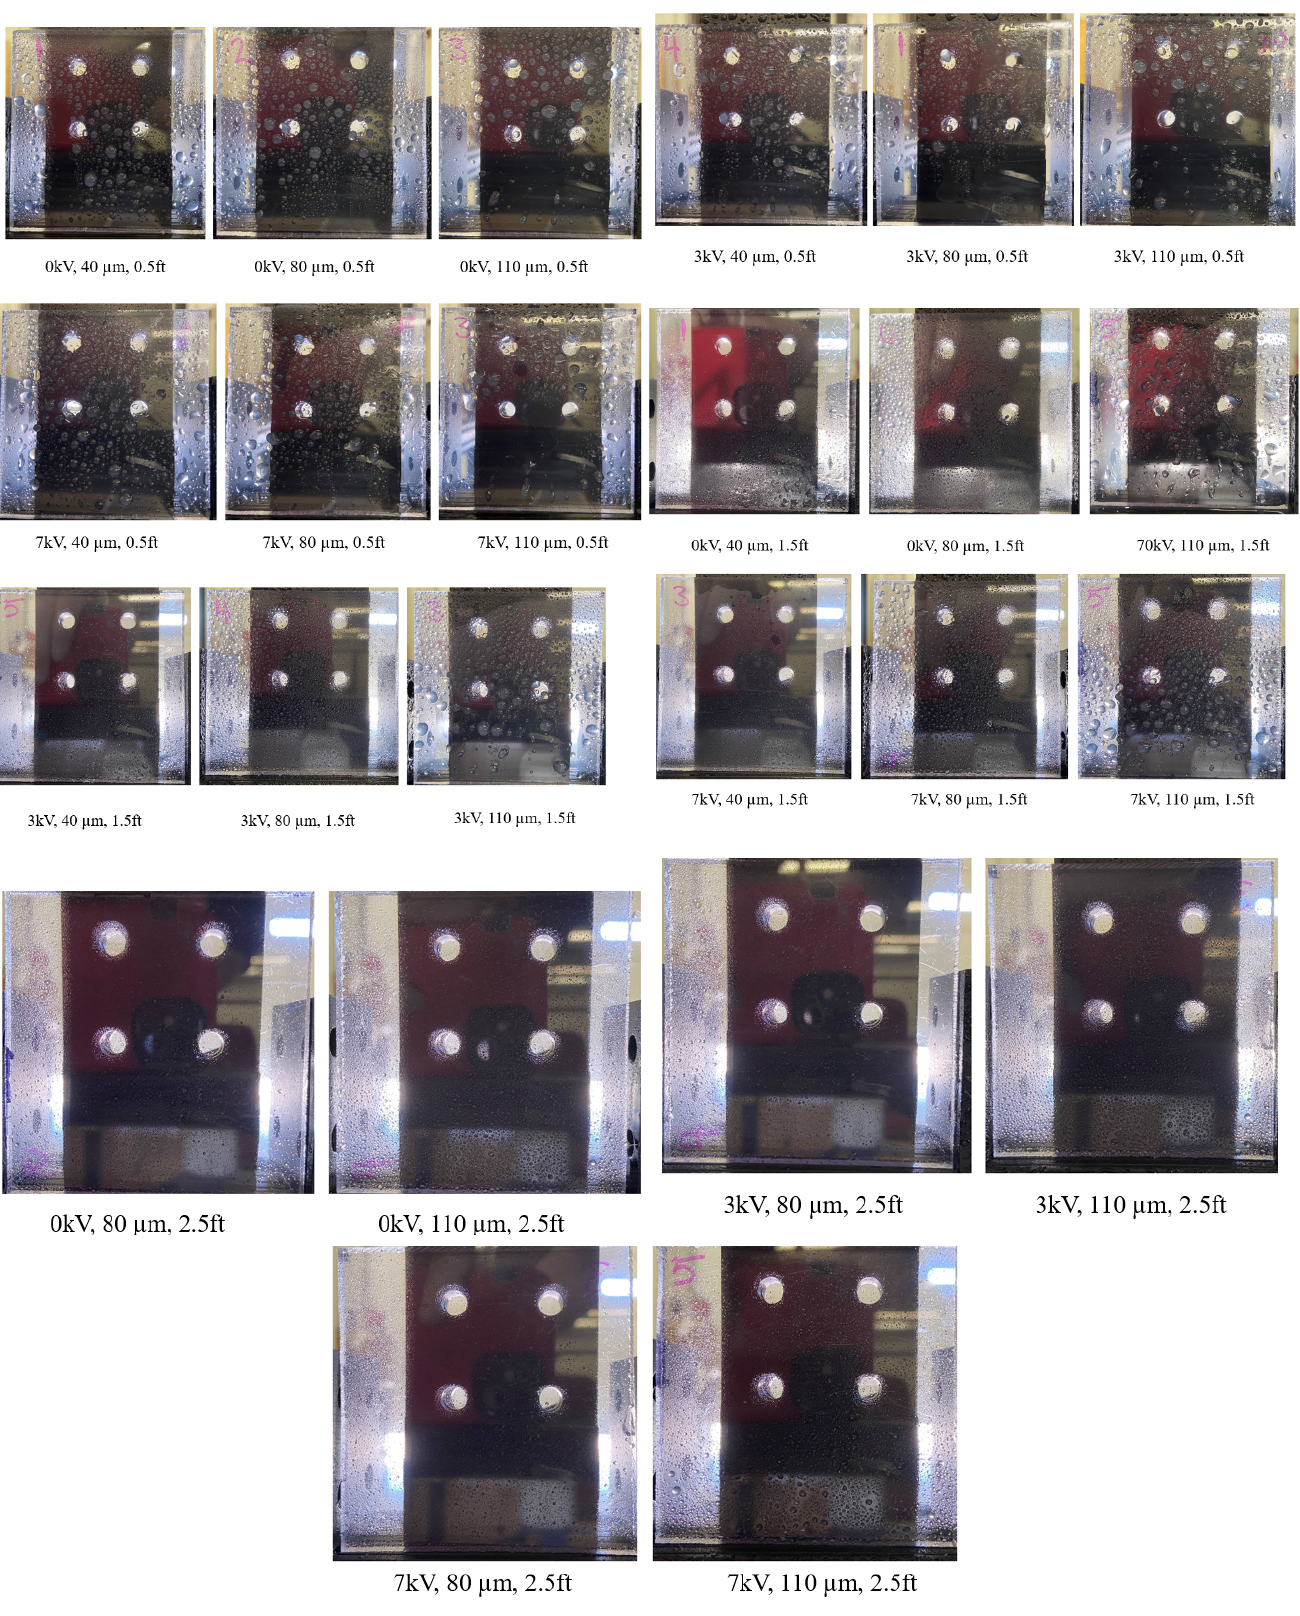
Figure A19. Polyethylene plastic: qualitative images of electrostatic deposition under various sys- tem